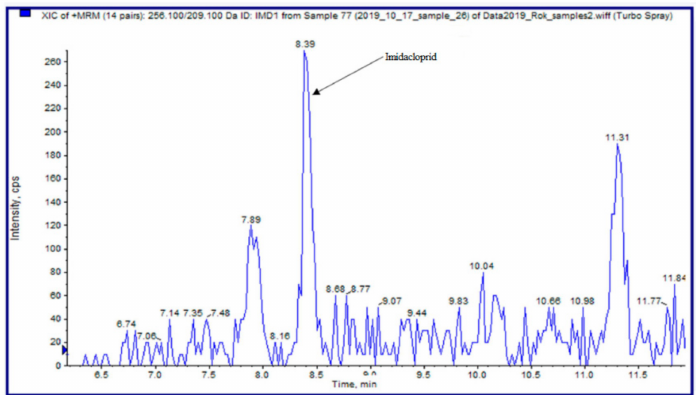
Figure 1. A section of a chromatogram of m / z transition for imidacloprid; extract of sample No.